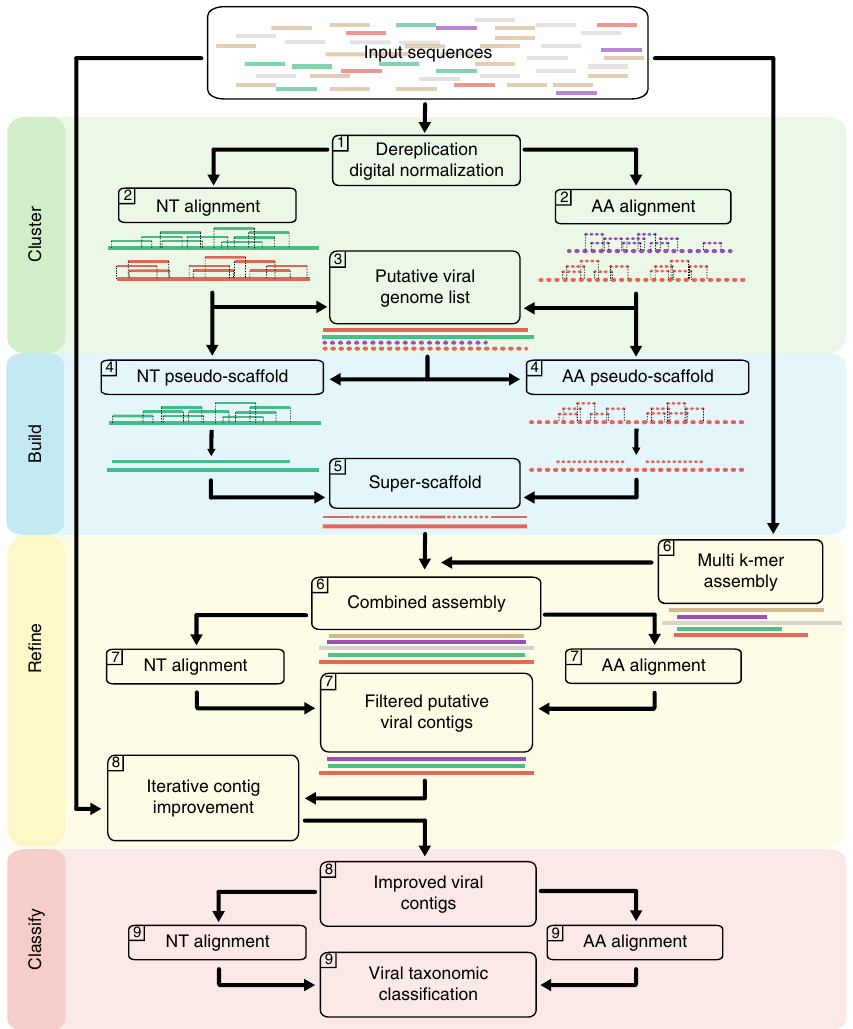
Fig. 1 A schematic overview of VirMAP. Data processing with VirMAP is achieved through four main stages (shaded colors) divided into nine major steps (top left corner). A putative list of viral genomes and protein pseudo-scaffolds are constructed from clustered nucleotide and translated alignments to the Genbank viral and phage divisions (gbvrl and gbphage). Nucleotide and amino acid pseudo-scaffolds are “ built ” and merged into a single super-scaffold per genome. A merged de novo assembly is constructed and merged in, resulting in contigs that are then re fi ned using an iterative rebuild process. The improved dual assembly is fi ltered against a comprehensive Genbank database and are taxonomically classi fi ed using a novel per-base contig